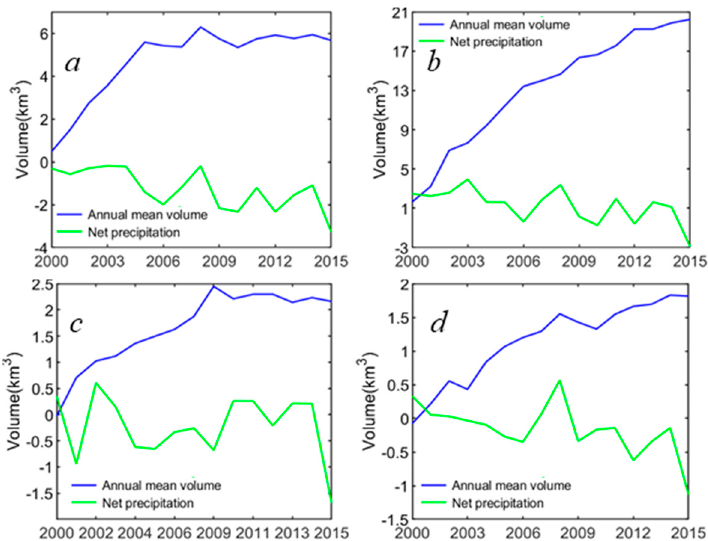
Figure 8. Net precipitation and lake volume changes on the yearly scale of Nam Co ( a ), Selin Co ( b ), Zhari-namco ( c ), and Ngangze ( d ) from 2000 to 2015.